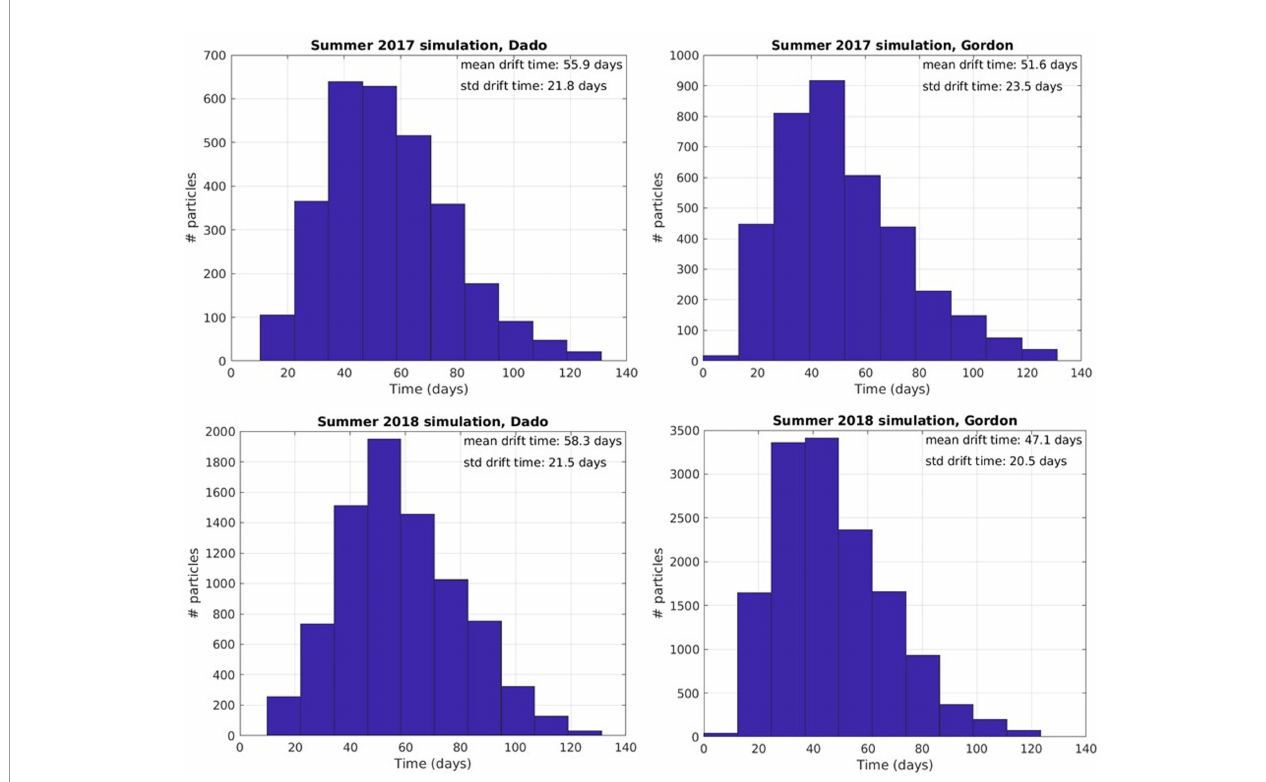
FIGURE 7 | Particle hit distribution on target beaches and mean drift time in days from release locations along the Egyptian coast (Between Alexandria and Bardawil) to Gordon (Tel Aviv) and Dado (Haifa) beaches in 2017 and